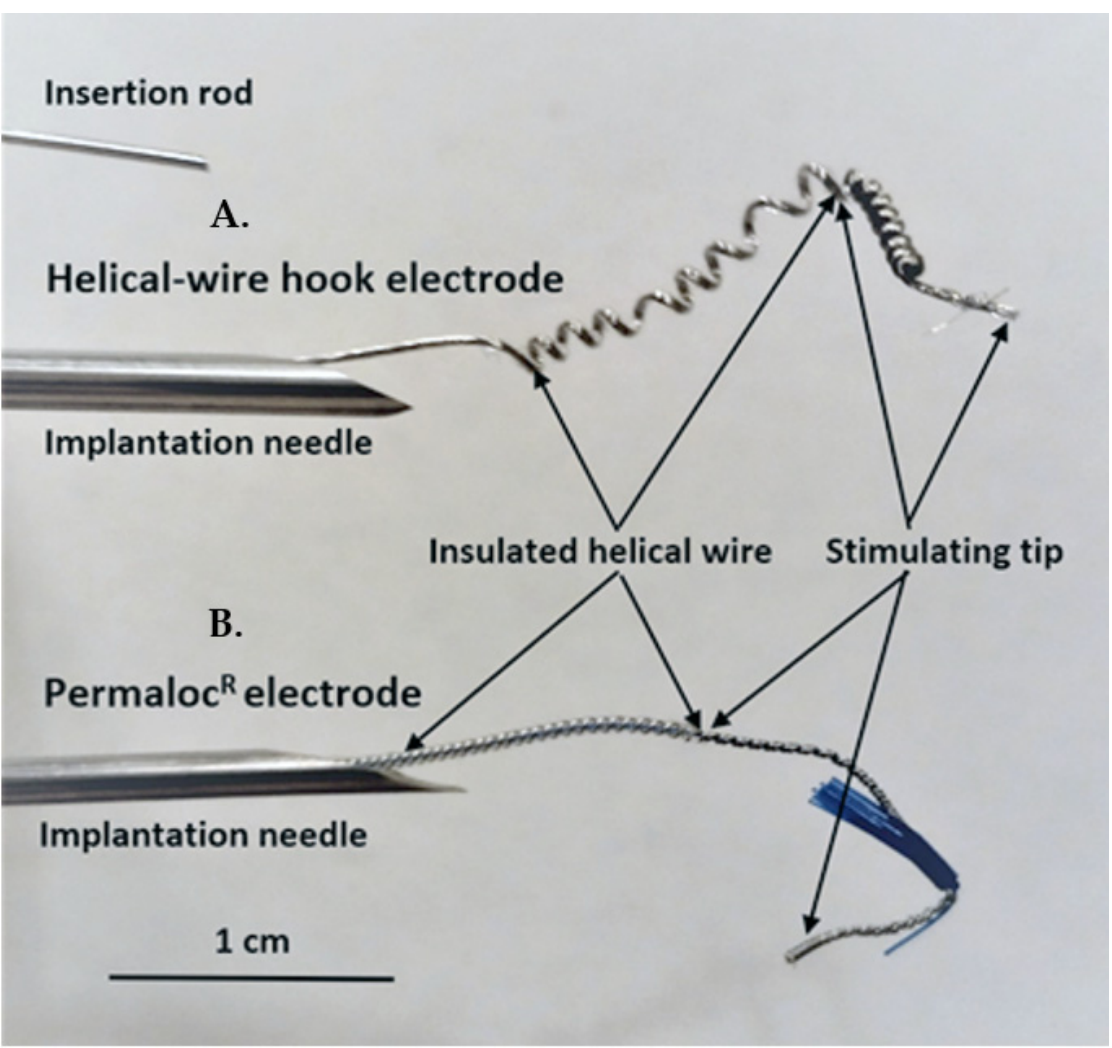
Figure 1. Photograph comparing the helical-wire hook electrode used in this study to the commercial Permaloc ® electrode used for respiratory pacing in SCI patients. ( A ) The lead of the helical-wire hook electrode is shown in a 14-gauge needle. The needle would be advanced up to the exposed hook of the stimulating tip prior to insertion. Needle insertion was used in the first minipig and implantation with imbrication on the bladder wall was used in the last two animals. An insertion rod is shown above the needles that is used to ensure accurate deployment of the electrode during needle insertion. ( B ) The Permaloc ® electrode was not used in this study but is shown for comparison. The constructing materials are the same for both electrodes.